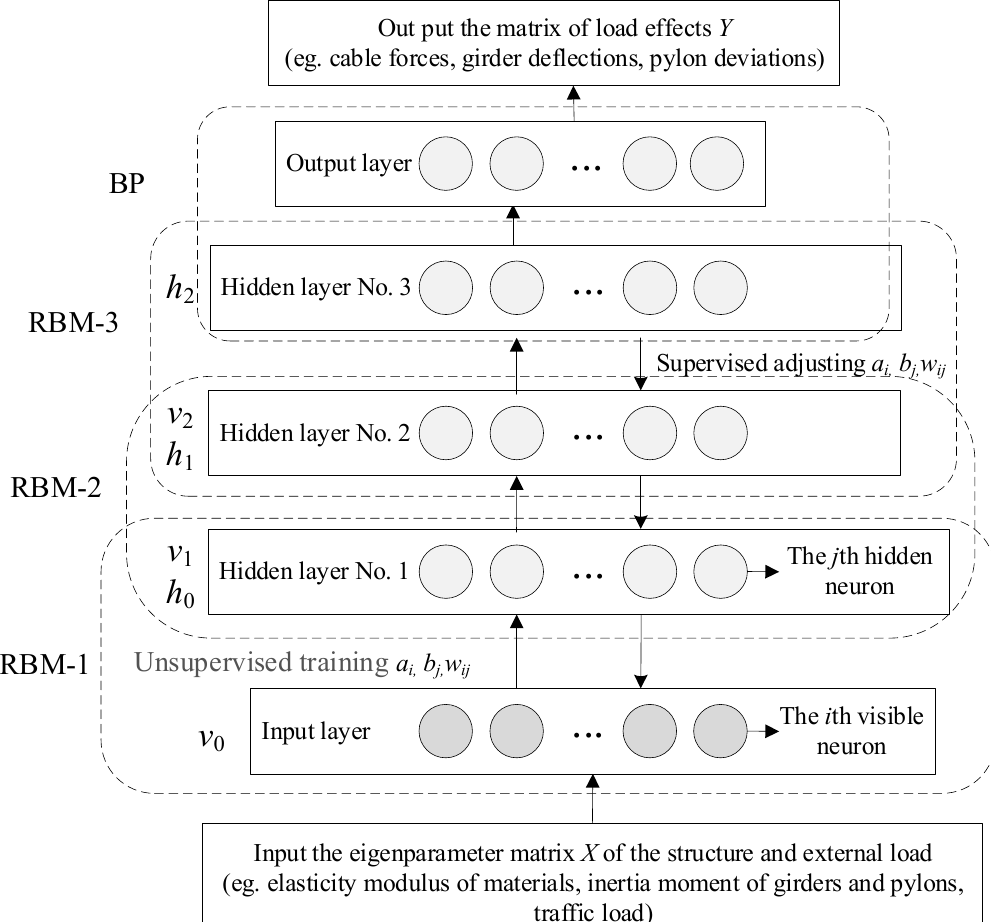
Figure 4. The DBN principle will be demonstrated below. Appl. Sci. 2020 , 10 , x FOR PEER REVIEW